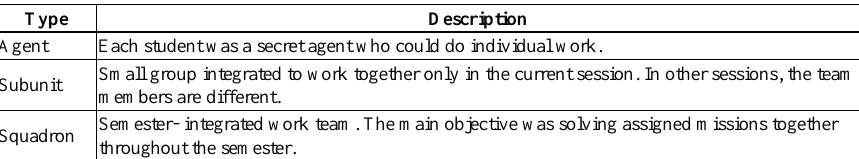
Table 1. Modalities of delivery of carrying out of